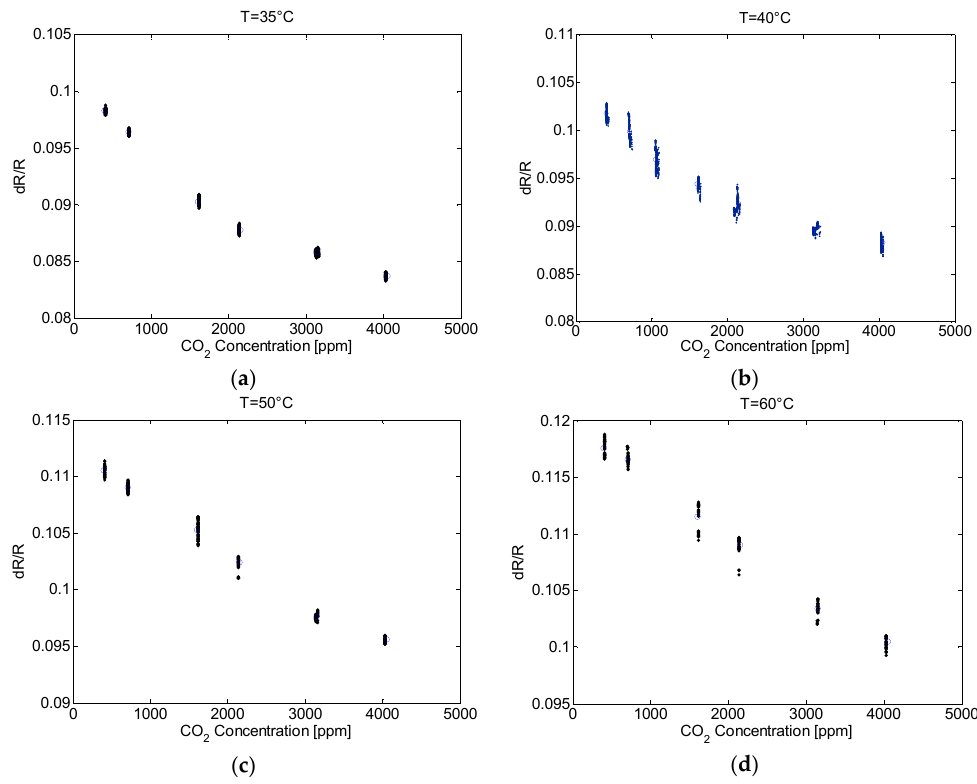
Figure 4. Printed sensor response in terms of relative variation of the output resistance for increasing values of the CO 2 concentration, for different values of the operating temperature: ( a ) 35 °C, ( b ) 40 °C, ( c ) 50 °C and ( d ) 60 °C. Vertical dots state for the dispersion of repeated observations of the sensor response; the circles are the mean values of repeated observations.